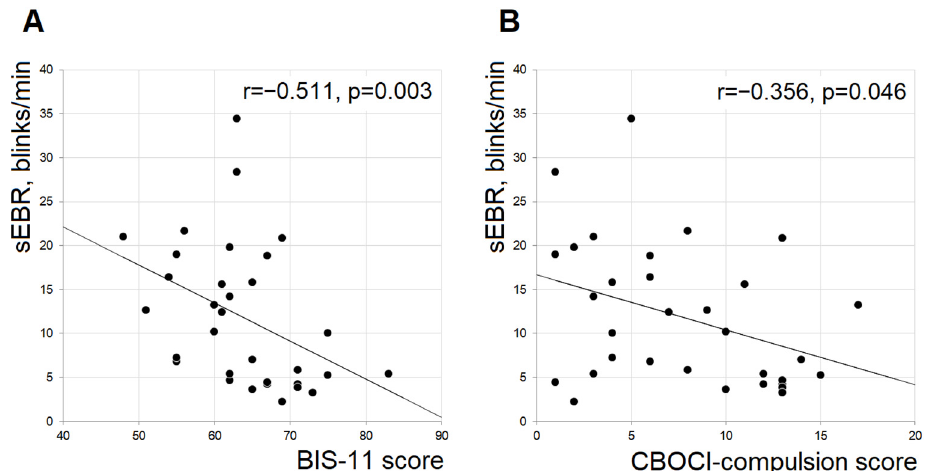
Figure 1. ( A ) Scatterplot of BIS-11 scores against individual sEBR values in PIU group; ( B ) scatterplot of CBOCI-compulsion scores against individual sEBR values in PIU group.